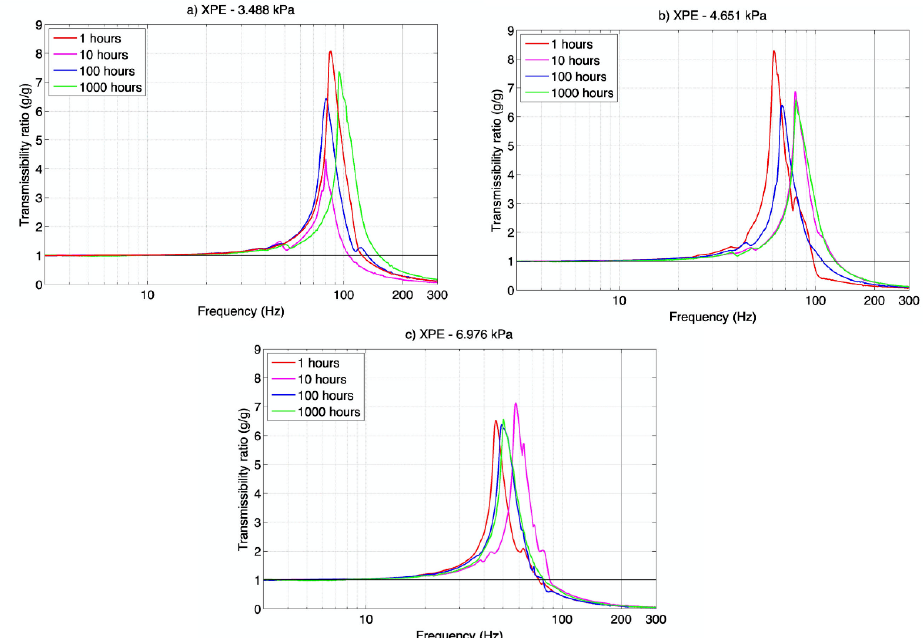
Figure 7. Vibration transmissibility and frequency curve for (a) XPE at a static load of 3.488 kPa, for (b) XPE at a static load of 4.651 kPa, for (c) XPE at a static load of 6.976 kPa Table 1. Vibration transmissibility and damping ratio of PE25, PE30 and XPE cushion materials Duration of Static